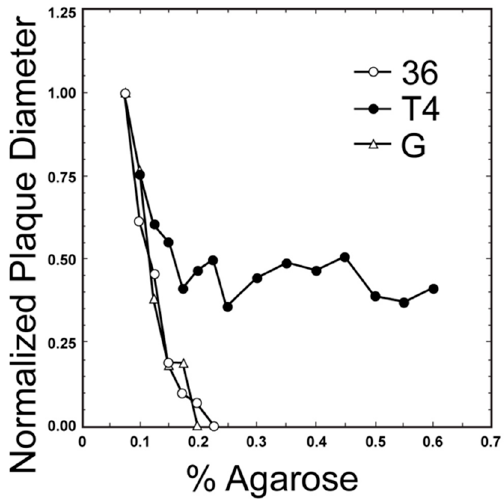
Figure 1. Plots of plaque diameter vs. A for phages (adapted from Figure 1 of reference [36]). Key: 36, phage 0305phi8-36; T4, phage T4; G, Phage G.